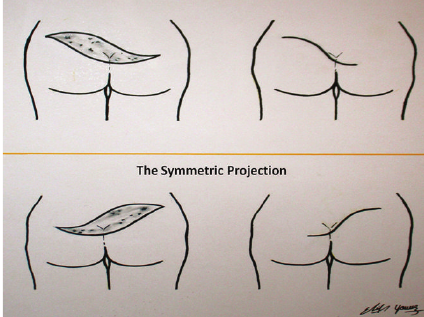
Figure 5: Illustration of the primary closure technique after S- shaped wide